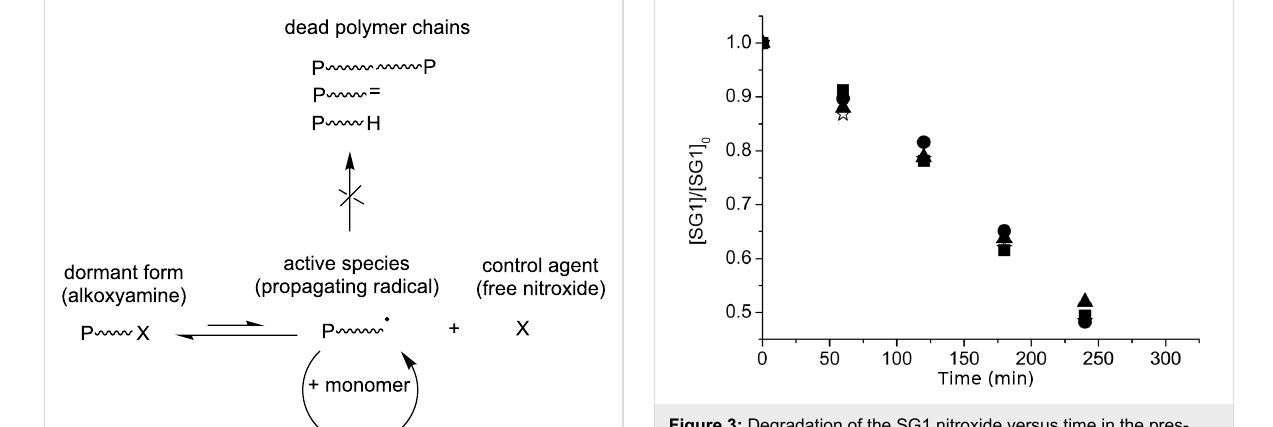
Figure 3: Degradation of the SG1 nitroxide versus time in the pres- ence of 0 (empty stars), 1 (filled squares), 10 (filled triangles) and 100 (filled circles) mol equivalents of D-glucose as measured by ESR in t -BuPh at 25 °C (samples heated in DMA at 120 °C and then diluted in t